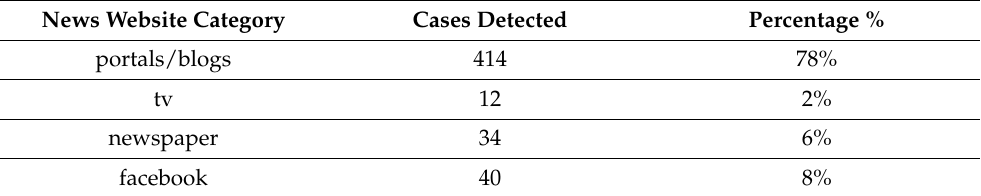
Table 3. Cases detected per website